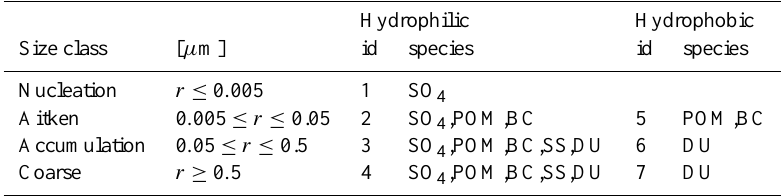
Table 1. ECHAM-HAM aerosol mode structure. Mode radii are constrained to the given size ranges. Identification numbers label the modes and are used in figures throughout the paper. Species composition differs by mode. Only the hydrophilic modes experience wet growth due to